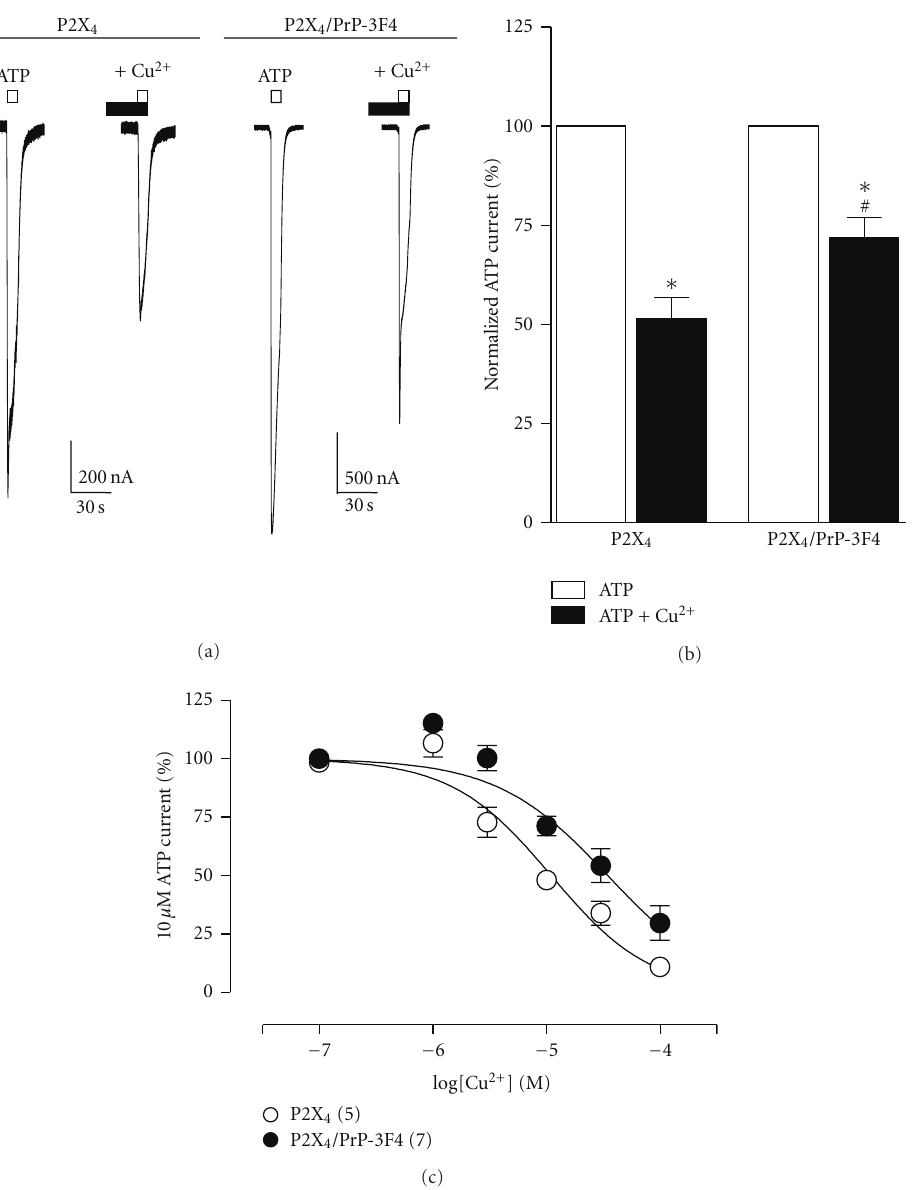
Figure 3: PrP C prevents Cu 2+ -induced inhibition of P2X 4 receptor. (a) Representative recordings obtained from oocytes expressing P2X 4 receptor (left traces, P2X 4 ) or coexpressing P2X 4 receptor and PrP-3F4 (right traces, P2X 4 /PrP-3F4) showing 10 μ M ATP-evoked currents ( open bars ) and its inhibition by 10 μ M Cu 2+ ( closed bars ). (b) Statistical analysis of Cu 2+ inhibition showed in (a), performed in di ff erent oocytes ( n = 12–14, ∗ P < 0 . 01 versus ATP, # P < 0 . 01 versus P2X 4 alone). Bars are mean values ± SEM. (c), Cu 2+ concentration-response curves of 10 μ M ATP inhibition in oocytes expressing P2X 4 receptor (open circles) or co-expressing P2X 4 receptor and PrP-3F4 (closed circles). Symbols are mean values ± SEM, numbers in parenthesis are number of